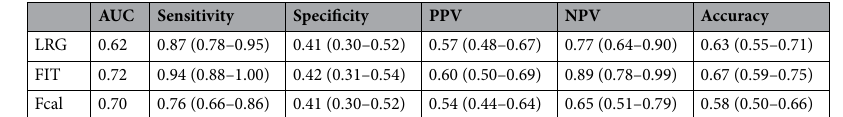
Table 3. Sensitivity, specificity, and predictive values of the serum/fecal biomarkers for MES 0 in UC patients with normal CRP levels (n = 140). Normal CRP: CRP ≤ 0.2 mg/dL. MES Mayo endoscopic subscore, UC ulcerative colitis, AUC area under curve, PPV positive predictive value, NPV negative predictive value, LRG leucine-rich alpha-2 glycoprotein, FIT fecal immunochemical test, Fcal fecal calprotectin, CRP C-reactive protein.